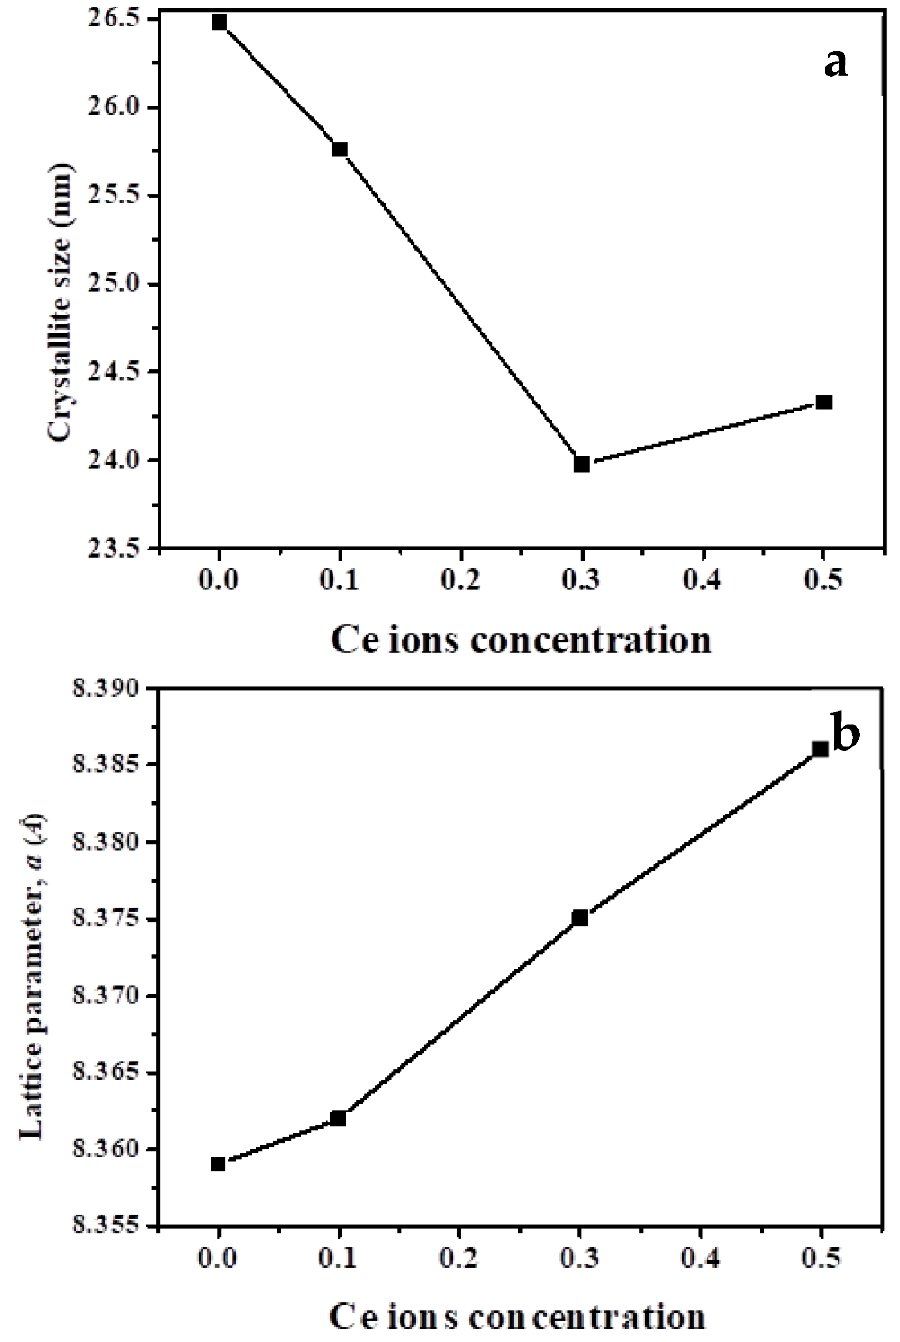
Figure 2. Crystallite size ( a ) and lattice constant ( b ) values of spinel MnCe x Fe 2 − x O 4 (x = 0.0, 0.1, 0.3 and 0.5)